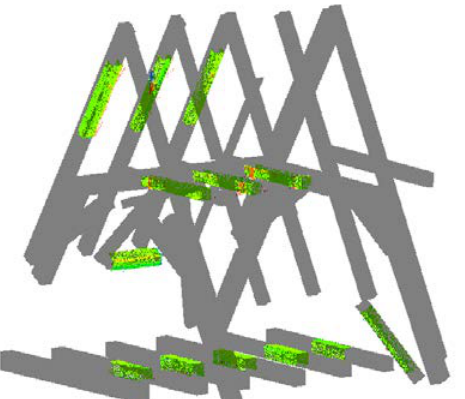
Figure 14: Manually selected beam sections for accuracy analysis. The color values of the points represent the distance from the modelled beams